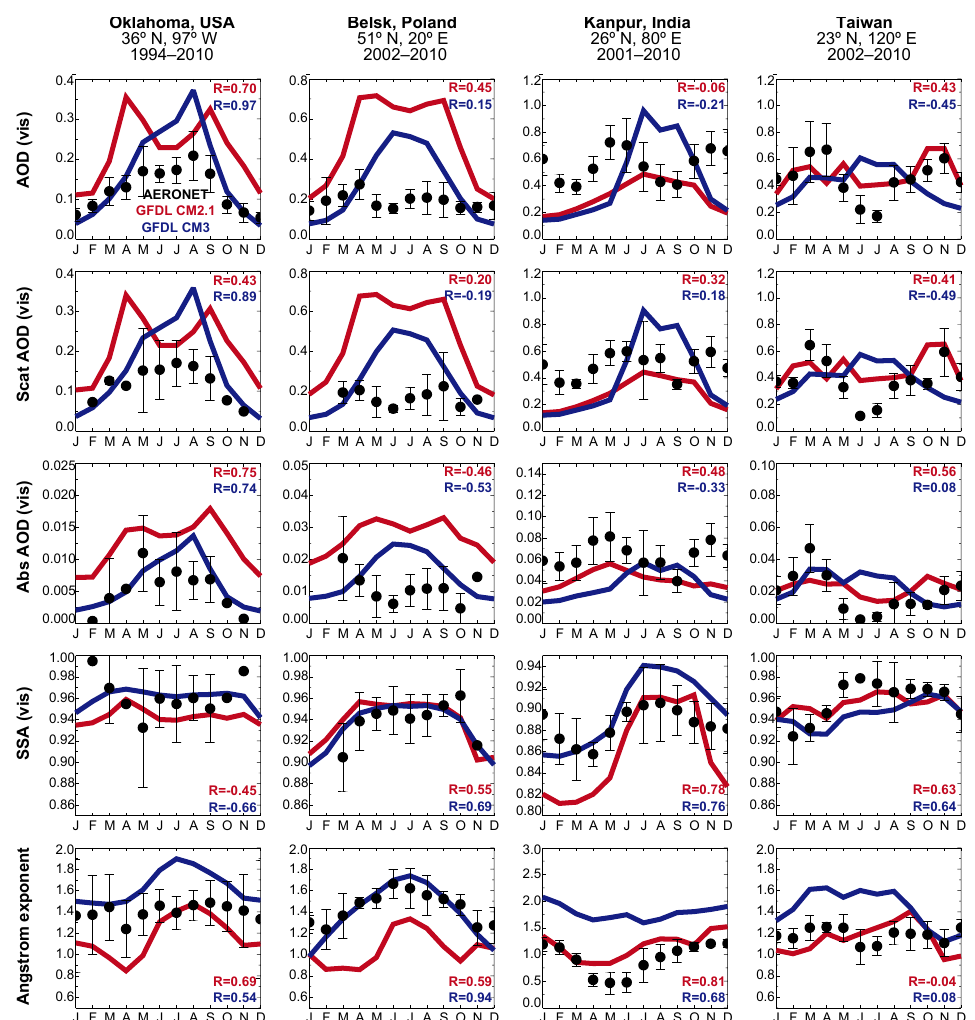
Figure 7. Optical properties from AERONET and the models for industrialized region sites. AERONET optical properties (circles) measured at 440nm but derived at 550nm (see text for details) and model optical properties (CM2.1: red lines, CM3: blue lines) calculated at 550nm. The error bars represent year-to-year variability of AERONET